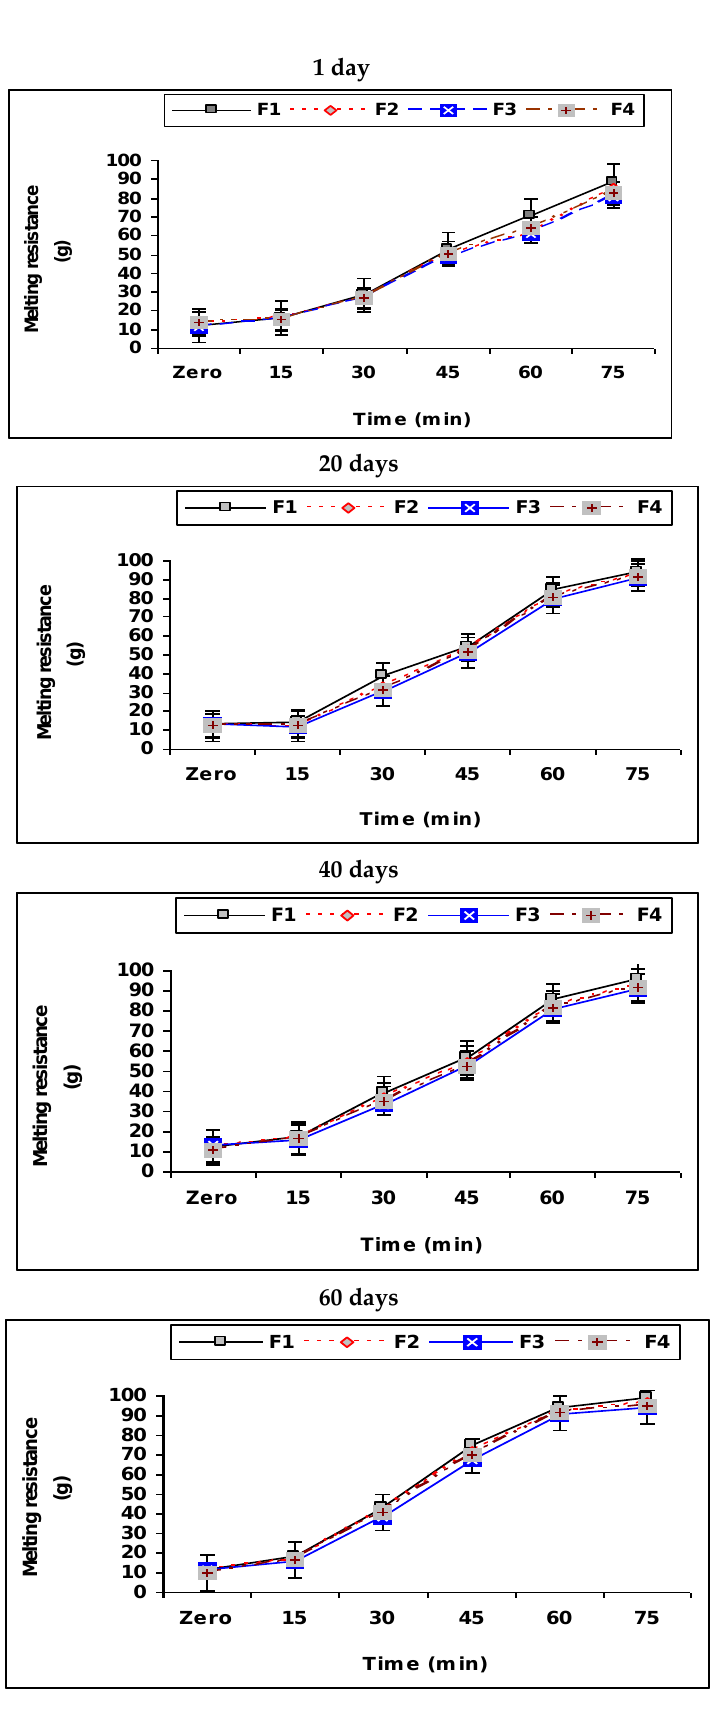
Figure 1. Melting resistance of probiotic-frozen yogurt during storage, F1: Control frozen yogurt; F2: Frozen yogurt with stevia; F3: Frozen yogurt with sucralose; F4: Frozen yogurt with sorbitol; Results within the same time frame not sharing a common letter are presented with SE ( p < 0.05).